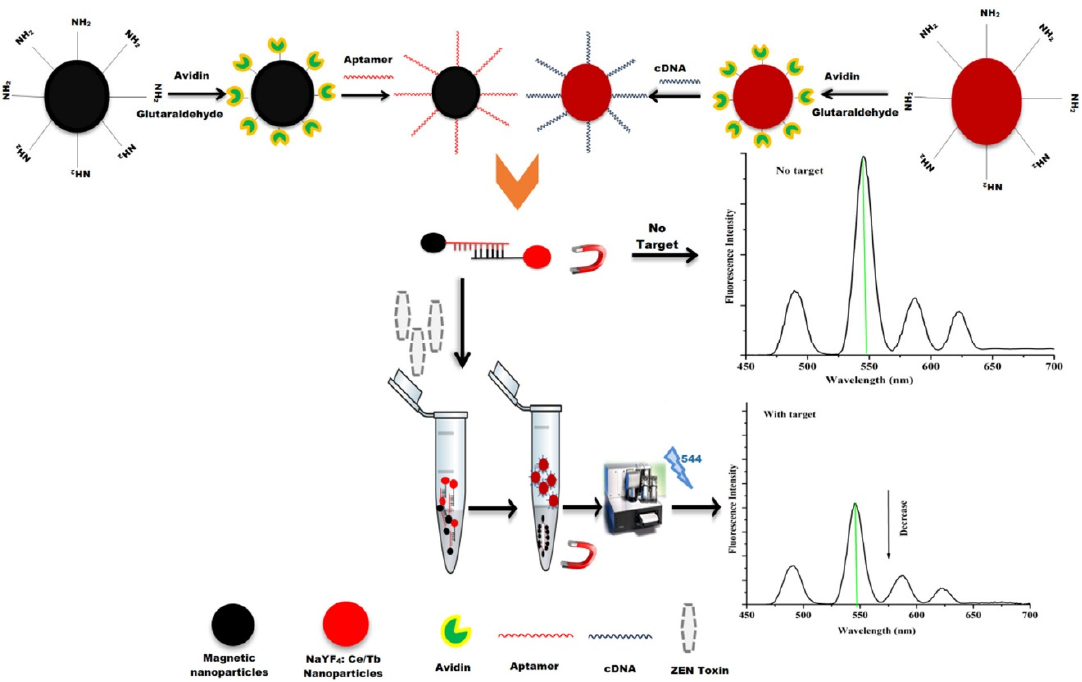
Figure 5. The detection principle based on MNPs as capture probe and fluorescent nanoparticles as a signal probe [124]